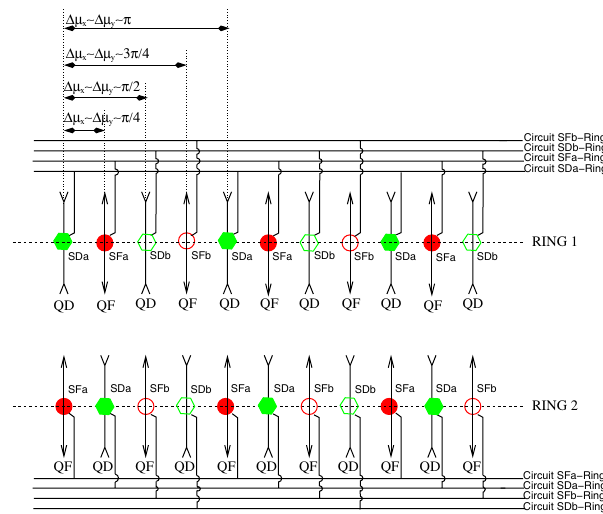
FIG. 3. Schematic layout of the LHC arc sextupole powering scheme [3]. For each beam, and in each arc of the machine, the focusing and defocusing sextupoles are split into two interleaved families. For the nominal LHC optics, the horizontal and vertical betatron phase advances are close to (cid:4) between two consecutive sextupoles belonging to the same family. These phases are matched to exactly (cid:4) for ATS